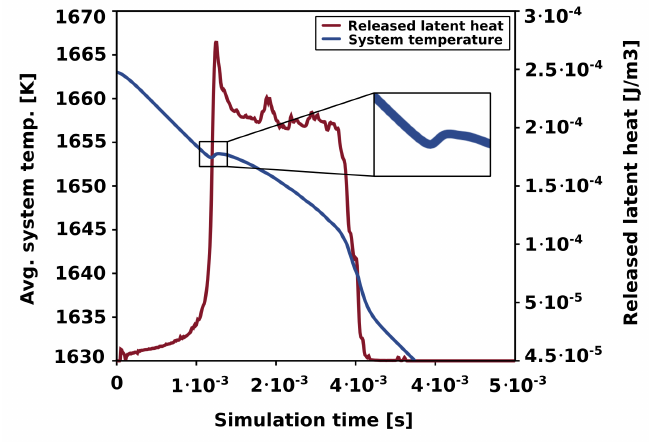
Figure 4. Plot of the averaged (avg.) system temperature and the amount of released latent heat over the simulation time with a magnification of the effect of